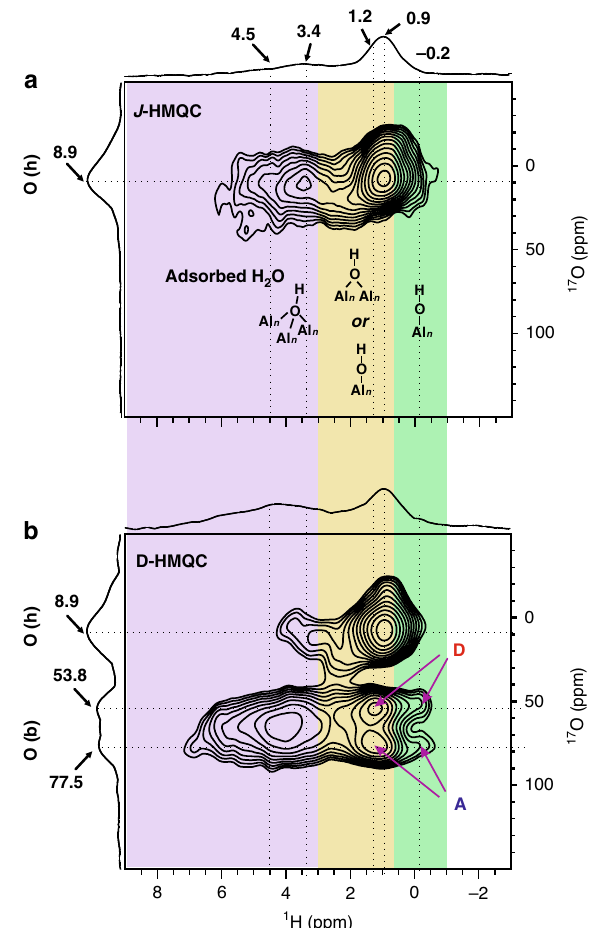
Fig. 3 Discrimination of surface oxygen species by 2D 1 H{ 17 O} HMQC experiments. a 2D 1 H{ 17 O} J -HMQC spectrum and b 2D 1 H{ 17 O} D- HMQC spectrum of γ -Al 2 O 3 with τ re = 1.05 ms recorded at 18.8 T. The background colors differentiate the hydroxyl groups based on their isotopic chemical shifts in the 1 H dimension. The oxygen species associated with hydroxyls and the bare oxygen species are denoted as O(h) and O(b), respectively. The structure of triply bridging, doubly bridging and terminal hydroxyls are displayed in Fig. 3a based on the distribution of respective 1 H chemical shifts. A and D indicate the speci fi c 4-coordinated and 3- coordinated oxygen sites, respectively, which are correlated with doubly bridging and terminal hydroxyls in Fig. 3b. The acquisition time for the J - and D-HMQC spectra is ca. 4.6 and 9.1 h,